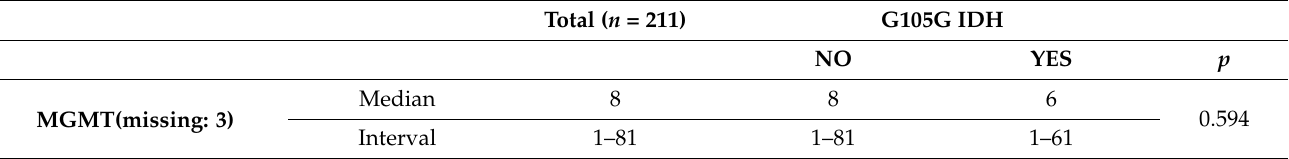
Table 2. Pathological and molecular characteristics according to IDH1 G105G SNP